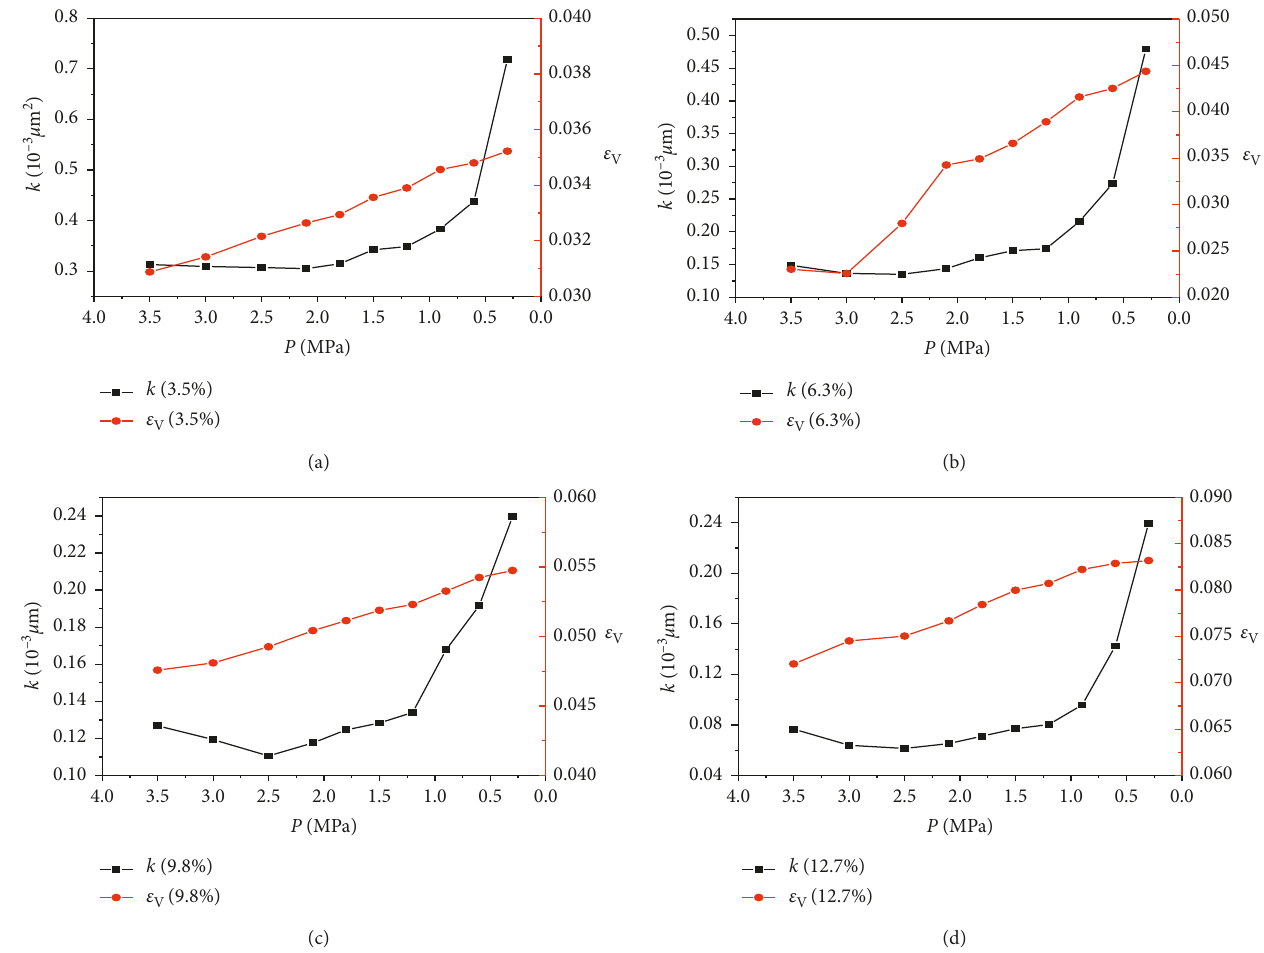
Figure 6: Relationships between volumetric strain-gas pressure and K during gas depressurization extraction for coal samples with moisture contents of (a) 3.5%, (b) 6.3%, (c) 9.8%, and (d)